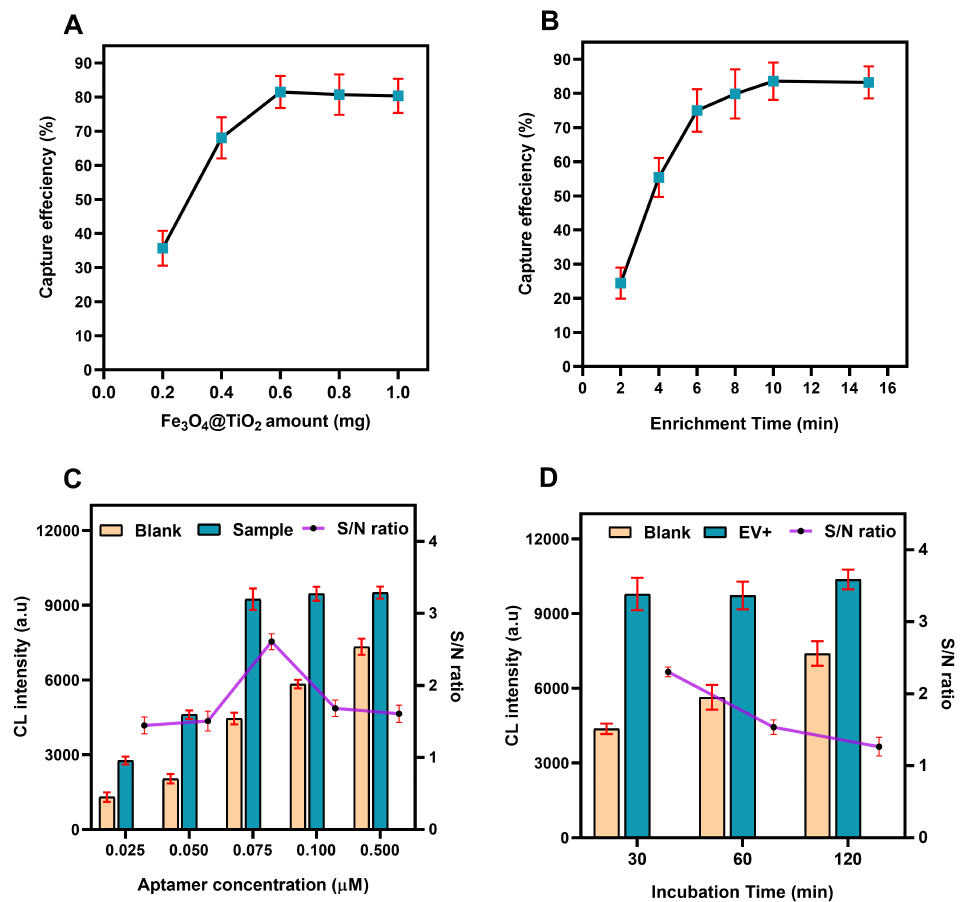
Figure 3. Optimization experiments. ( A ) Fe 3 O 4 @TiO 2 amount and optimal capture efficiency. ( B ) Fe 3 O 4 @TiO 2 incubation time and optimal capturing potential. ( C ) Aptamer concentrations for optimal performance of the assay. ( D ) Aptamer incubation time for optimal assay performance. (Error bar indicates the standard deviation of three replicates, S/N = signal-to-noise